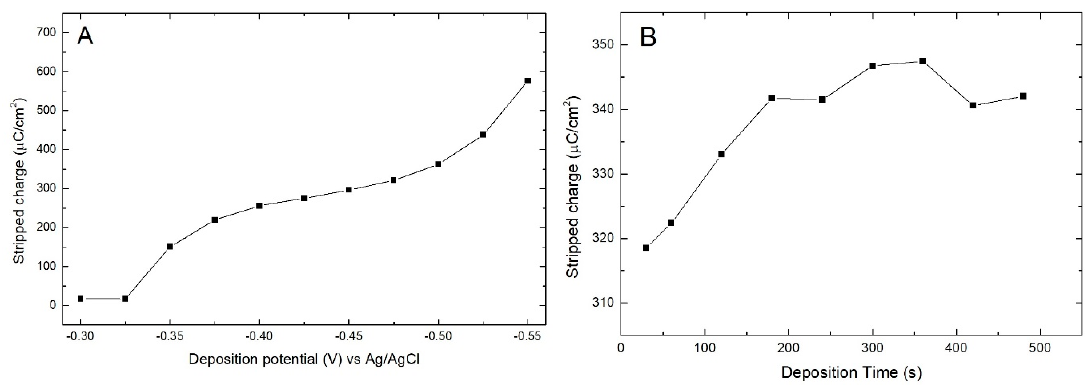
Figure 8. ( A ) Growth of the amount of Bi deposited in one minute on Ag electrode in function of the deposition potential; ( B ) amount of deposited Bi with a potential fixed at − 0.45 V depending on the deposition time.